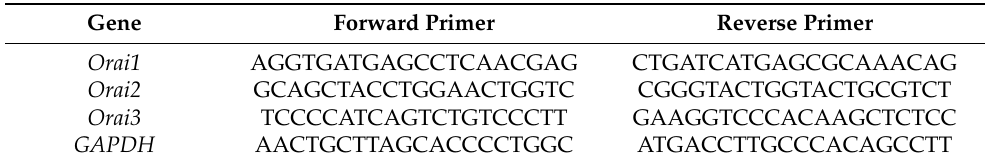
Table 2. Sequences of primers used in the